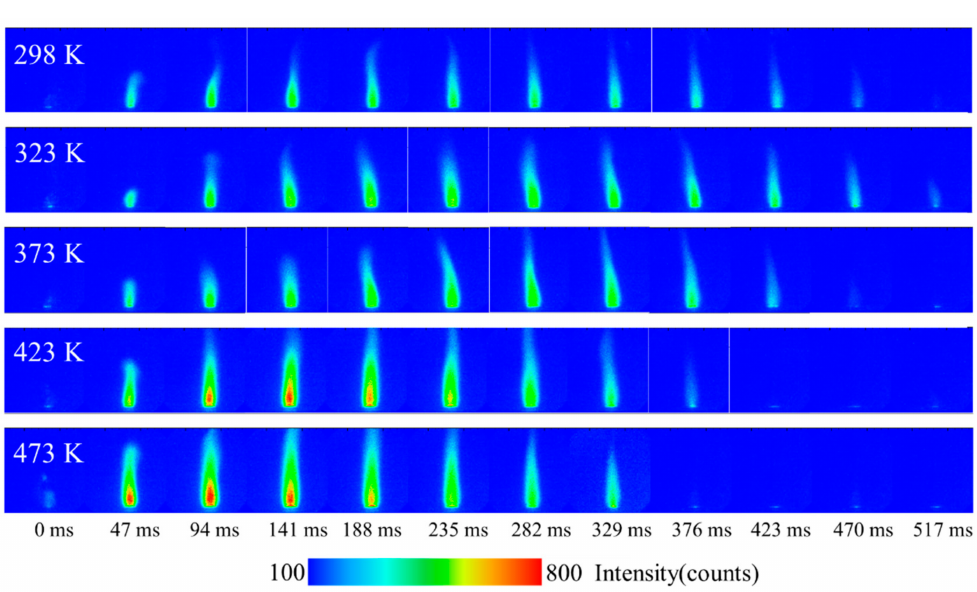
Figure 10. The distribution of NO chemiluminescence signal in flames at different times and initial